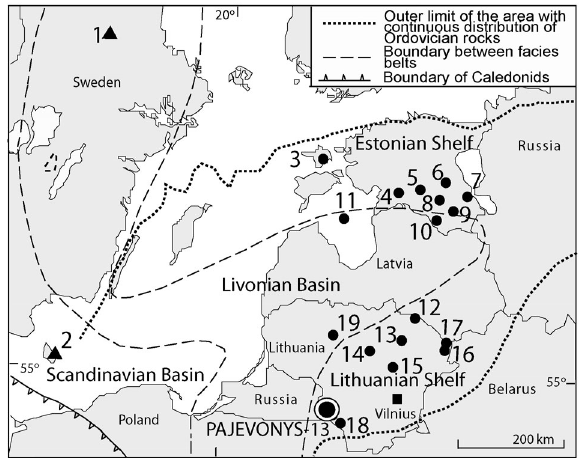
Fig. 2. Major palaeogeographic features of the Baltic Basin (modified from Harris et al. 2004) and localities in Estonia and Sweden. Outcrops (black triangles): 1, Fjäcka, main section; 2, Bornholm, outcrop in the Vasågard area; drill cores (black circles): 3, Männamaa-F367; 4, Ristiküla-174; 5, Viljandi-91; 6, Tartu-453; 7, Mehikoorma-421; 8, Kaag- vere; 9, Otepää; 10, Valga-10; 11, Ruhnu-500; 12, Butku- nai-241; 13, Svedasai-252; 14, Krekenava-7; 15, Ukmerge-10; 16, Drukšiai-5; 17, Kazimirovo-6; 18, Kalvaria-2; 19, Kurtu-